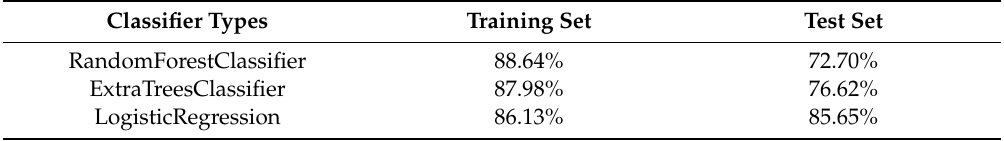
Table 8. Accuracy using di ff erent classifiers.